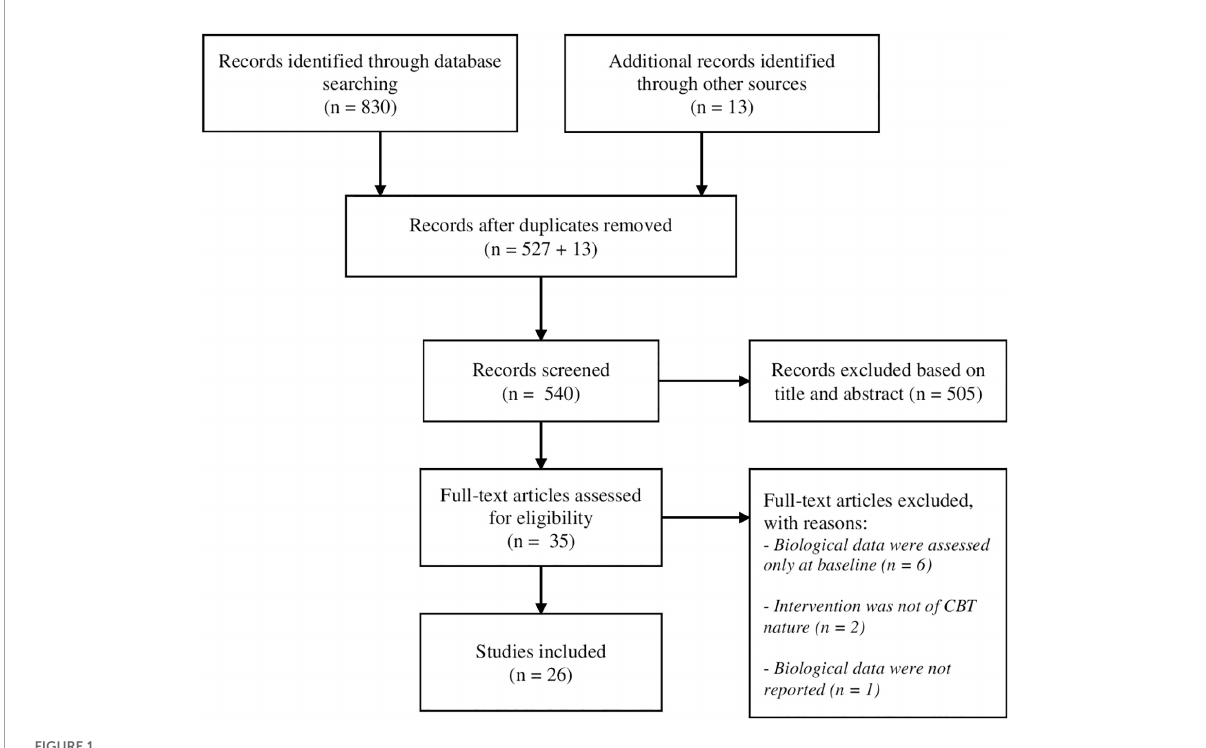
FIGURE1 PRISMA flow diagram of search